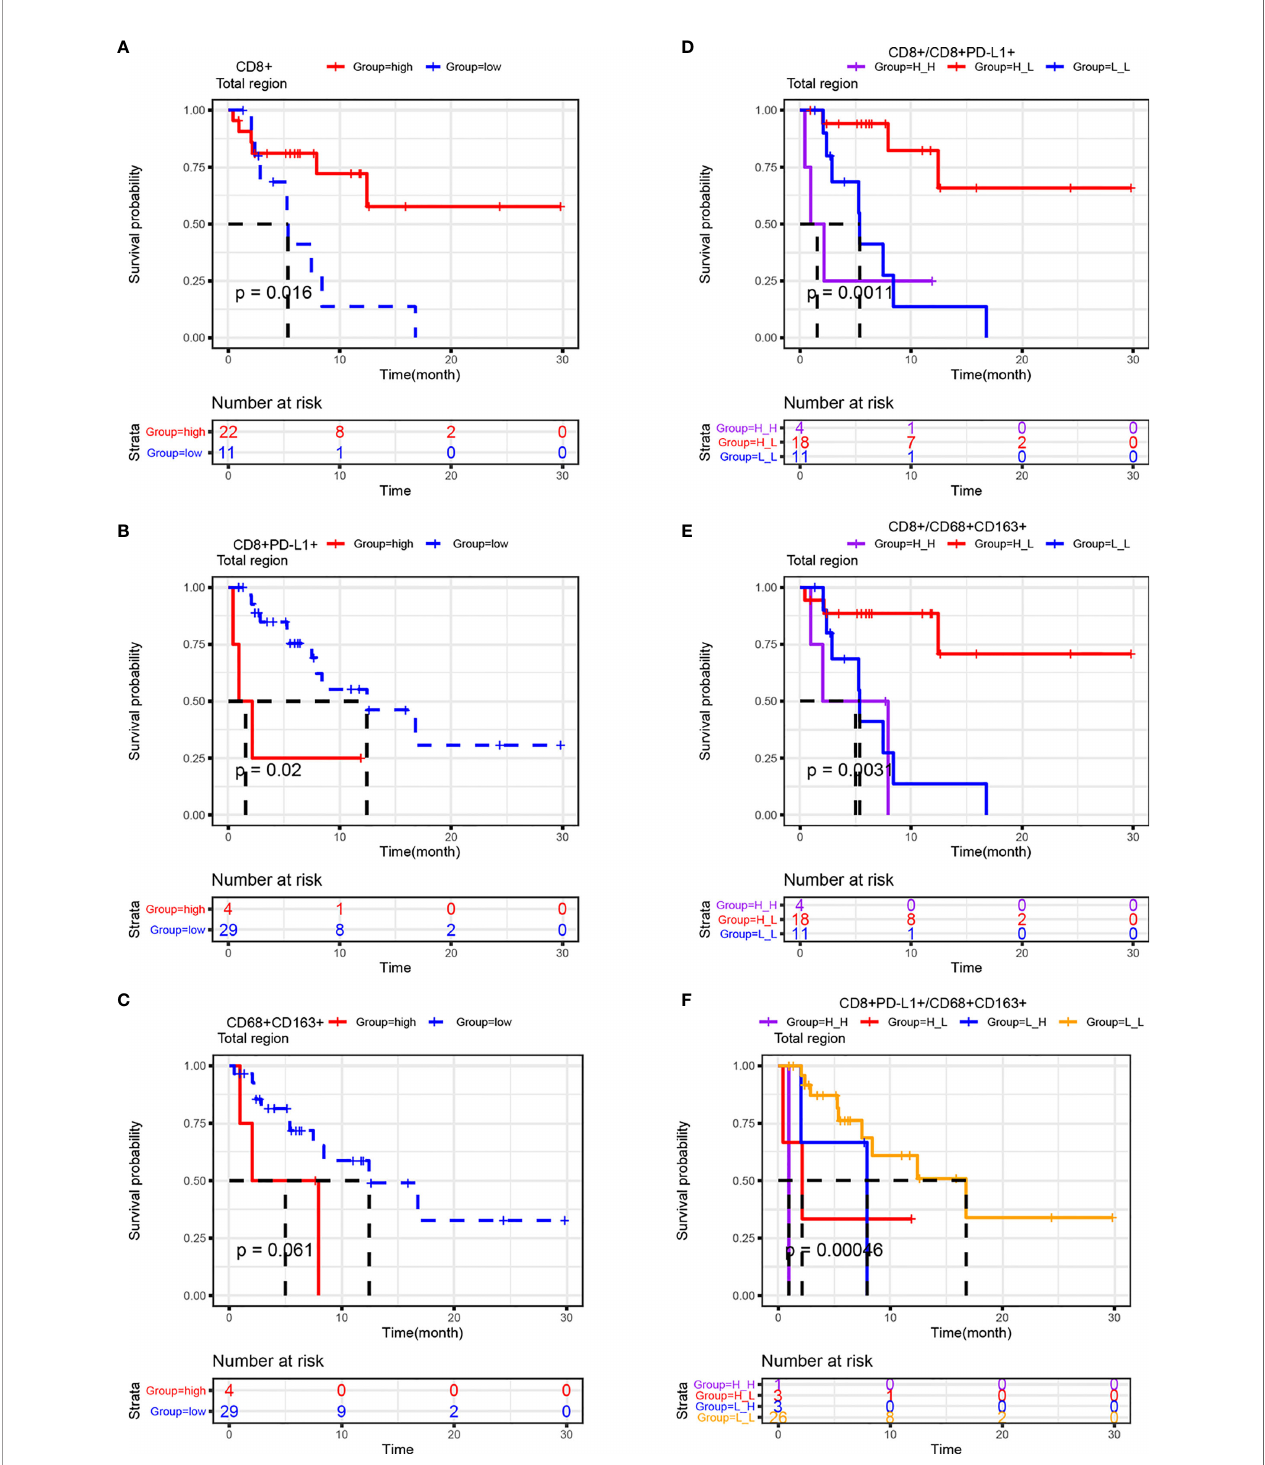
FIGURE 4 | Prognostic roles of CD8+, CD8+PD-L1+, CD68+CD163+ and related joint parameters. Kaplan-Meier analysis of the progression-free survival of NSCLC patients strati fi ed by their CD8+ (A) , CD8+PD-L1+ (B) , CD68+CD163+ (C) or joint parameter results (D-F) for the total region. The cutoff point for TAICs (high vs low) was determined using the survminer package in R software. Higher in fi ltration of CD8+ and lower in fi ltration of CD8+PD-L1+ T cells were correlated with improved progression-free survival. The results also indicated that CD8+ high/CD8+PD-L1+ low, CD8+ high/CD68+CD163+ low, and CD8+ low/CD68+CD163+ low NSCLC patients had better PFS than the other three corresponding types of